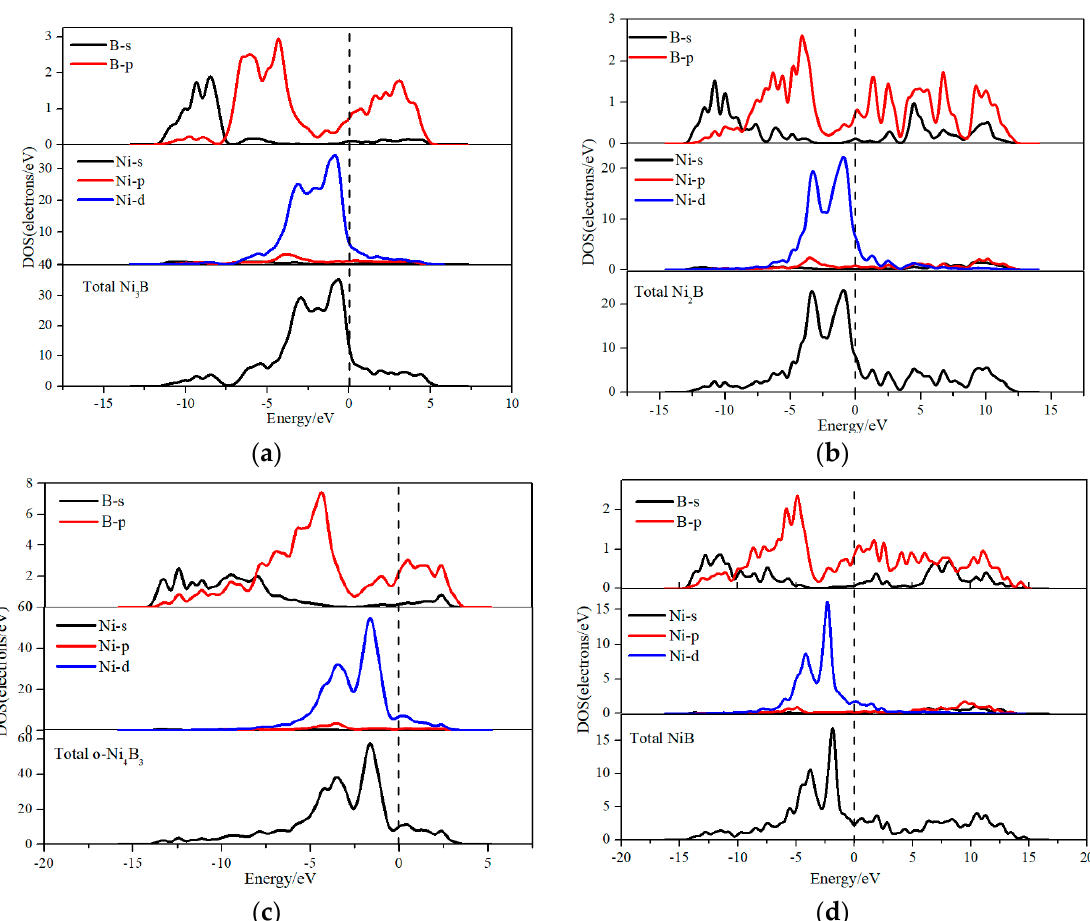
Figure 5. Total density of states (TDOS) and partial density of states (PDOS) for Ni x B y compounds. Dashed lines represent the Fermi level: ( a ) Ni 3 B; ( b ) Ni 2 B; ( c ) Ni 4 B 3 ; ( d ) NiB.